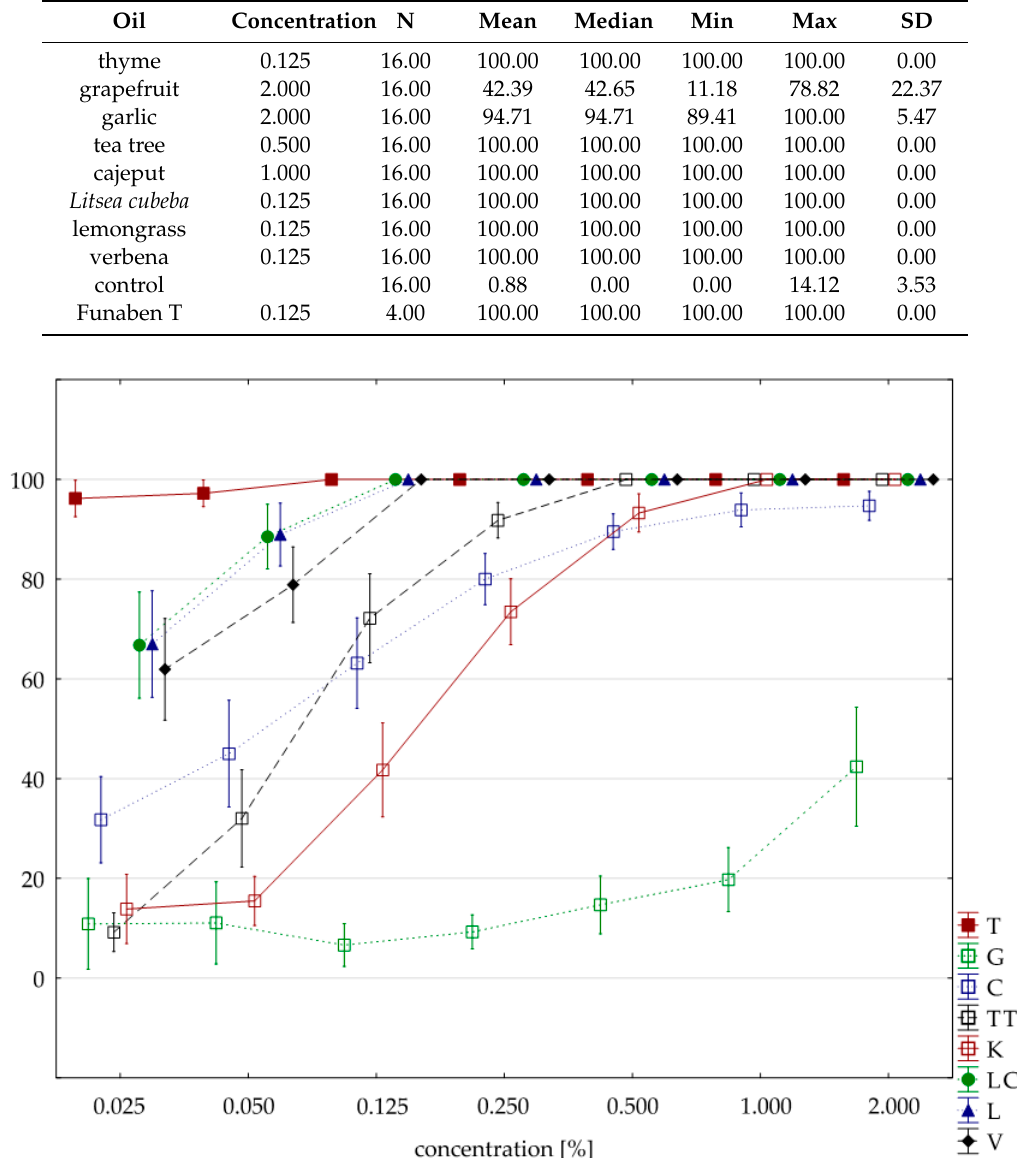
Table 9. Descriptive statistics on the assessment of fungistatic activity of essential oils at the tested oils concentrations in relation to Fusarium isolates (combined analysis).